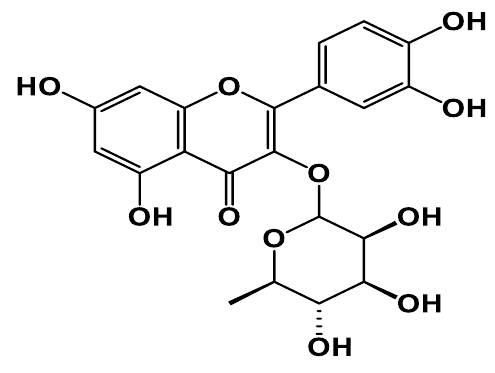
Figure 1. Quercetin 3-O-rhamnoside